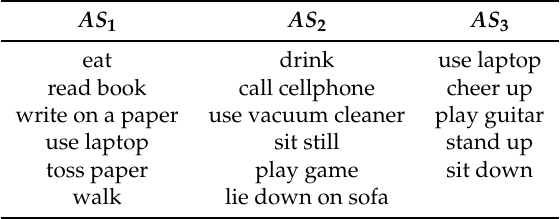
Table 3. Subsets of actions, AS 1 , AS 2 , and AS 3 in the MSR Daily Activity 3D dataset [23].